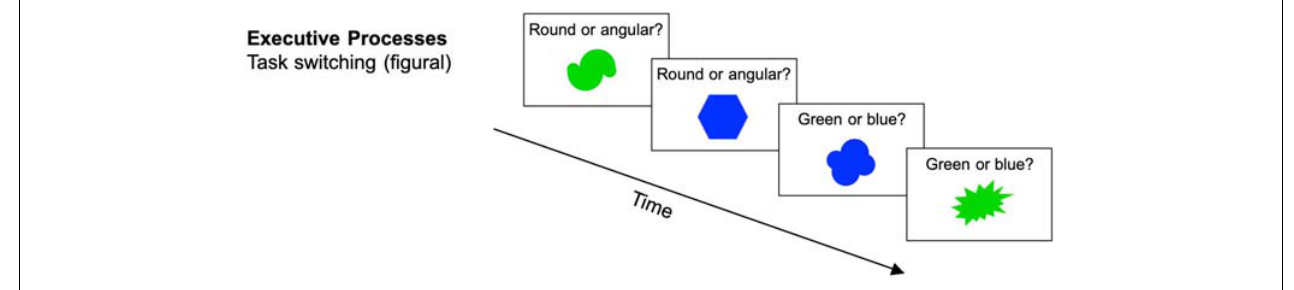
FIGURE 3 | Executive processes task (task switching) (reused and adapted with permission from Langer et al., 2013). Participants were presented with stimuli on which they had to decide if they were round vs. angular or green vs. blue dependent on the current task (Langer et al., 2013; von Bastian et al.,